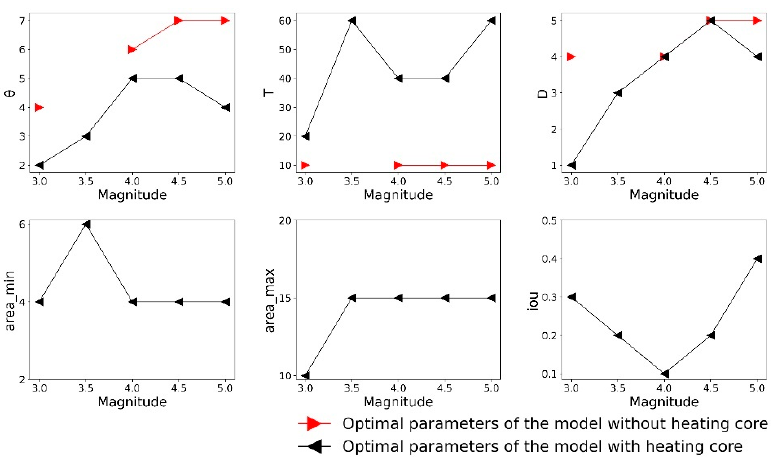
Figure 6. The optimal parameters of the models with/without a “heating core” when the resampling scale is 100 under different magnitude parameters.